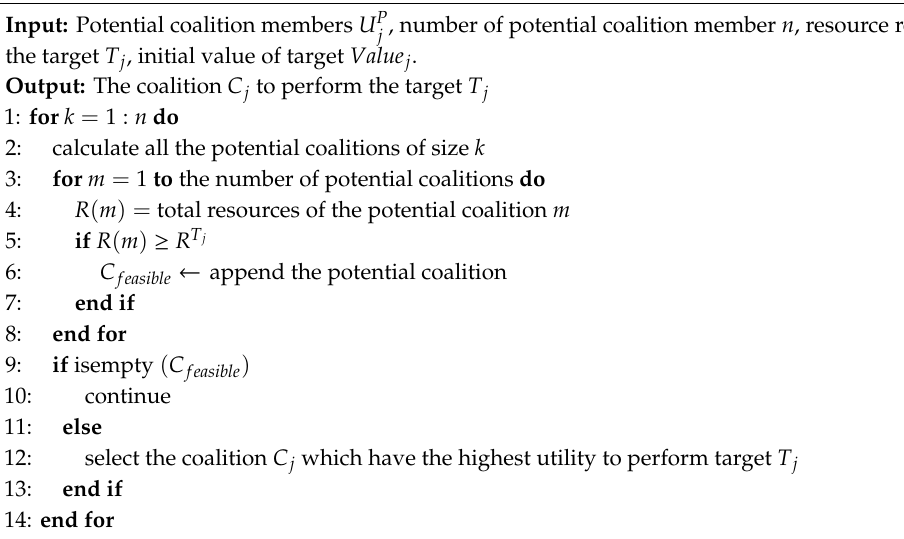
Algorithm 2. Select the coalition C j to perform target T